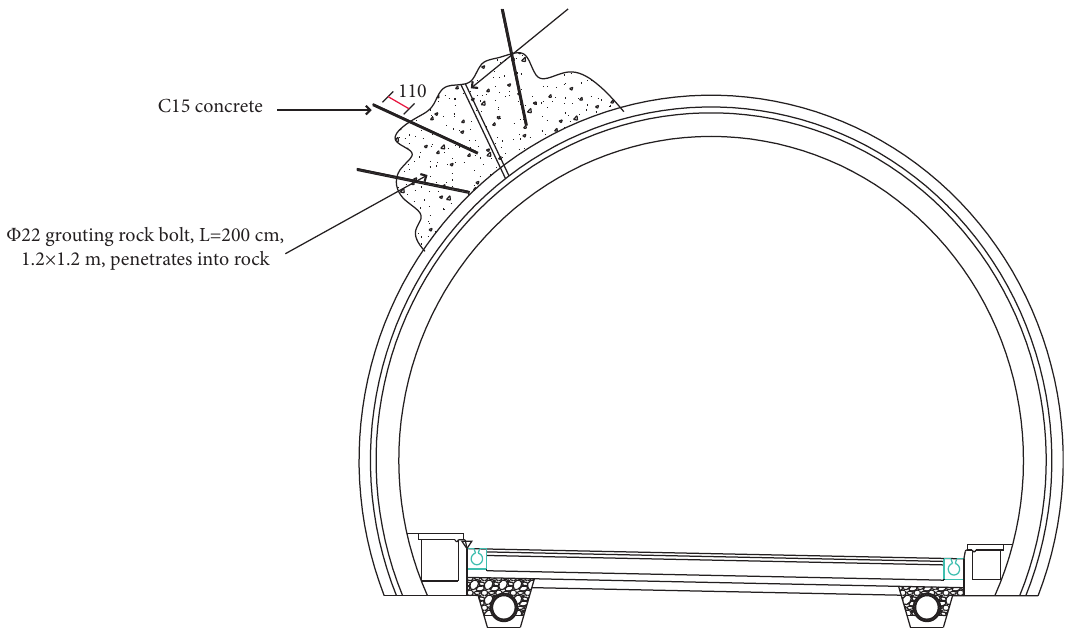
Figure 5: Small karst cavern above the arch waist.